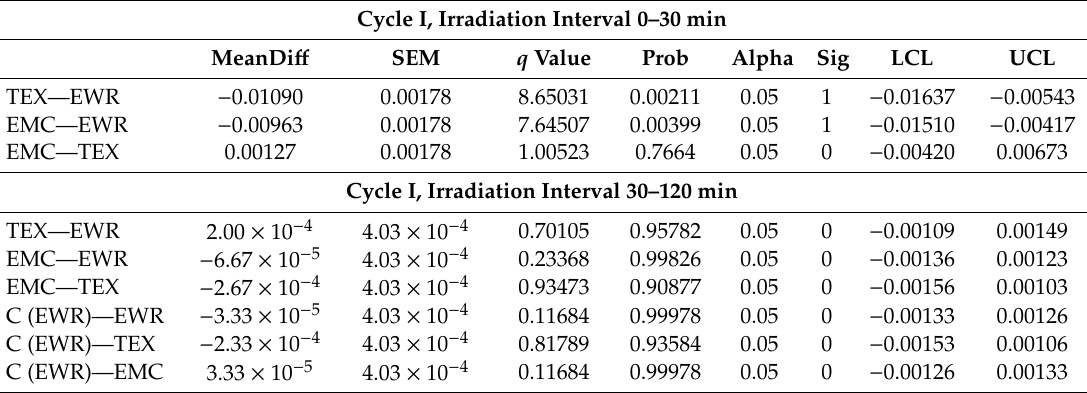
Table 4. Tukey test results for data collected from experiments carried out in Cycle I.